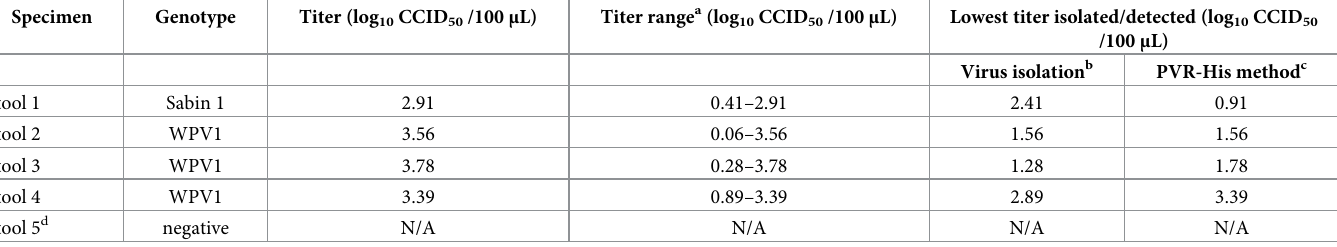
Table 4. Comparison of virus isolation and the PVR-His protein capture method on limiting dilutions of PV1-positive stools. The lowest titer of poliovirus by culture and the lowest titer of poliovirus detectable by the PVR-His capture assay is listed.